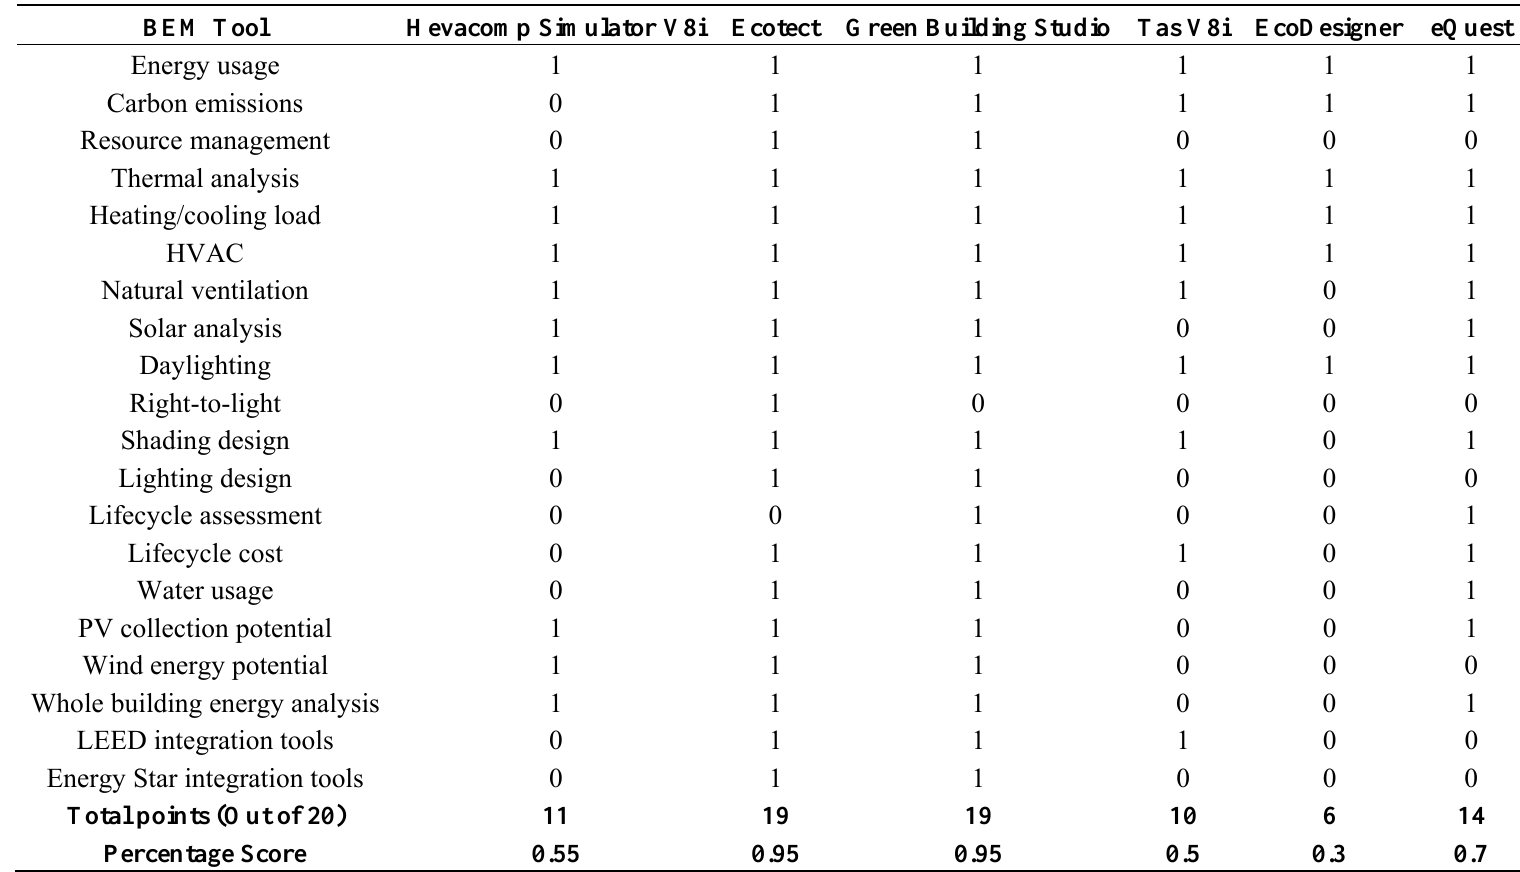
Table A6. Initial evaluation: available outputs criterion calculations for BEM tools (Part